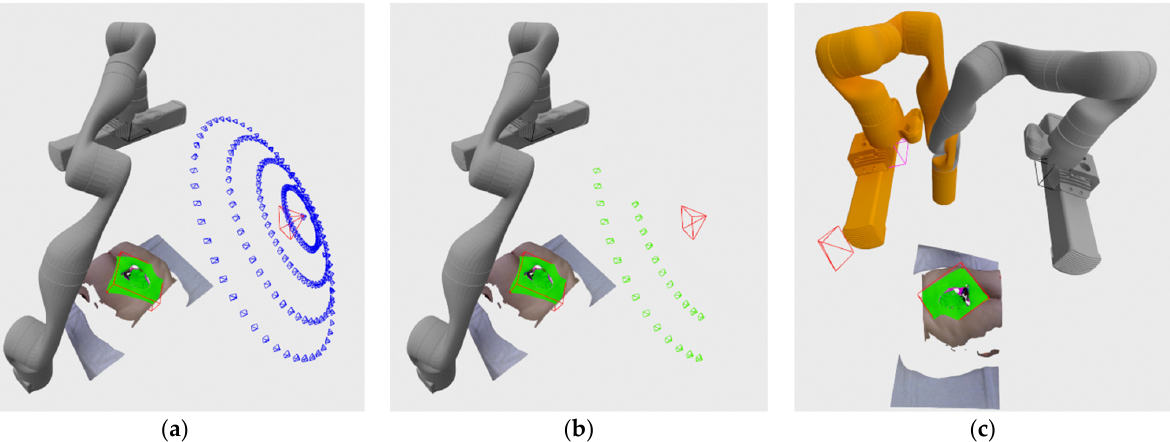
Figure 13. ( a ) Nearby hypothesis generated in a sphere pattern (blue) around the requested pose (red); ( b ) reachable nearby poses represented as green cones; ( c ) robot arm configuration in the nearby pose chosen as the NBV (orange).